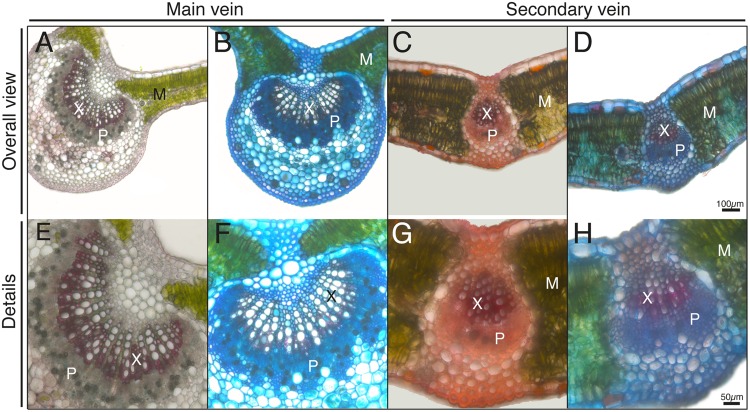
Histological staining from transversal leaf sections. Sections were incubated with safranin (A,C,E,G) or safranin + alcian blue (B,D,F,H). Lignin structures are stained in red and cell walls in blue. Phloem and xylem tissues (P and X, respectively) and mesophyll tissue (M) are marked in the Figure. The scale bars correspond to 100 μm in (A–D) and 50 μm in (E–H).